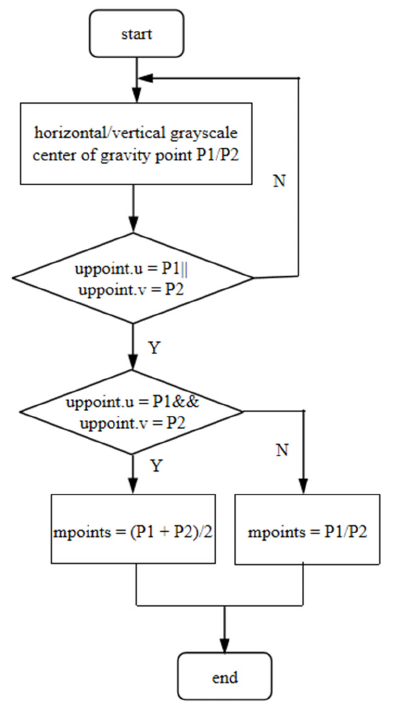
Figure 9. Flow chart of bidirectional center of gravity method.